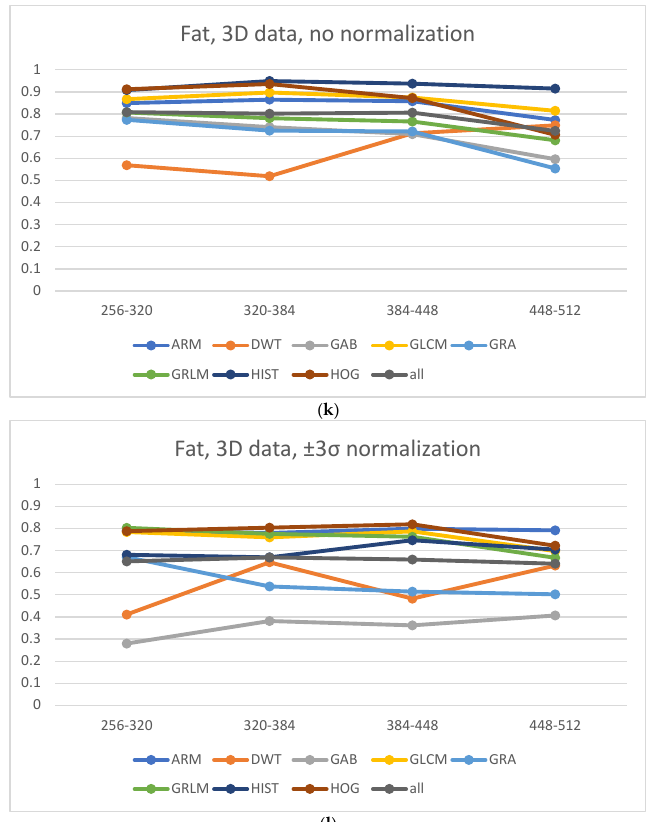
Figure 7. Average Lin’s coefficients for analyzed texture features evaluated between neighboring matrices. ARM — Autoregressive Model, DWT — Discrete Wavelet Transform (Haar wavelet), GAB — Gabor Transform, GLCM — Grey Level Coocurrence Matrix, GRA — Gradient matrix, GRLM — Grey Level Run-Length Matrix, HIST — Histogram, HOG — Histogram of Oriented Gradients.